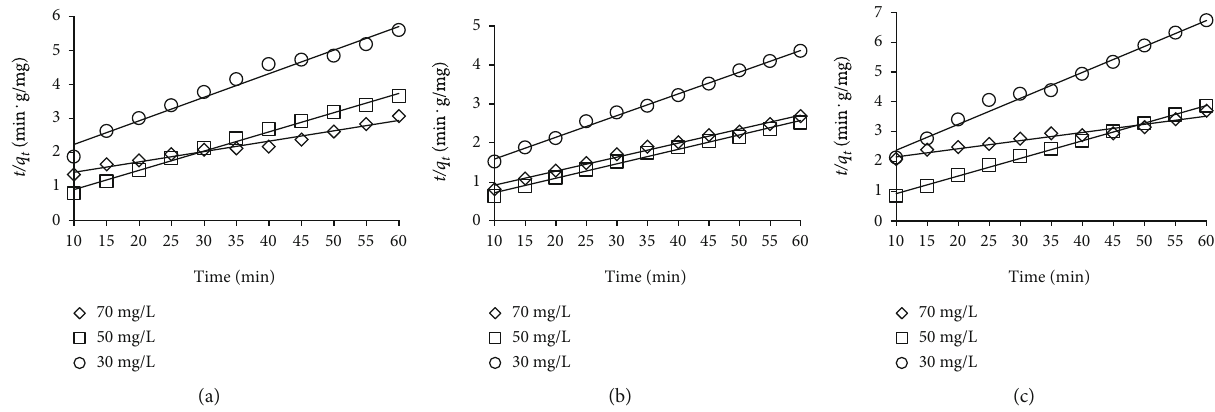
Figure 15: Pseudo-second-order kinetic plot for adsorption of (a) Pb (II), (b) Cr (III), and (c) Cd (II) on amidoxime chelating resin for di ff erent initial feed concentrations at pH5 and temperature at 25 ° Table 1: Kinetic constant parameters obtained for heavy metal adsorption on polyamidoxime resin. Pseudo- fi rst order Metal